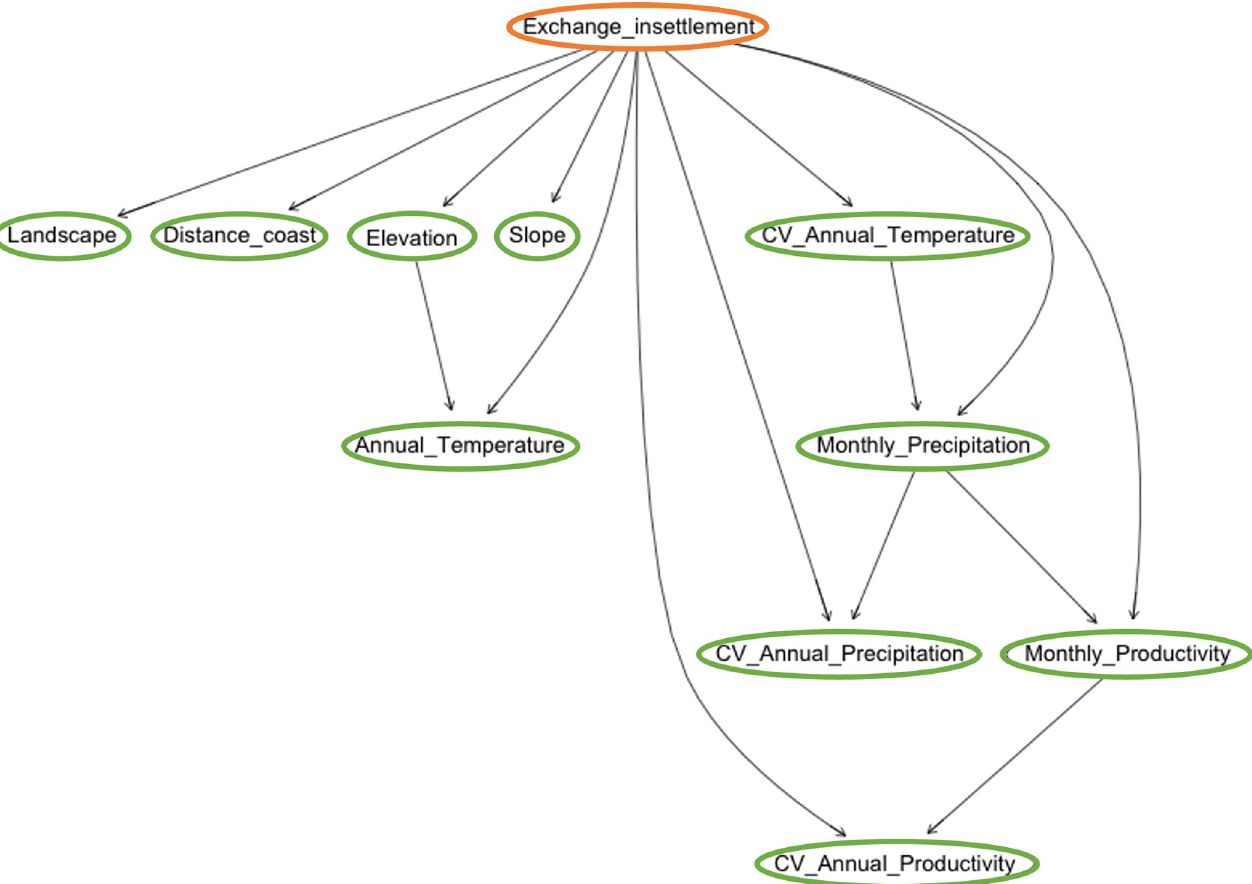
Fig 7. Model A-ANB investigating the relationship between the environment and social decisions. Dependence between ecological variables (inputs, green) and exchange in-settlement (output, orange).